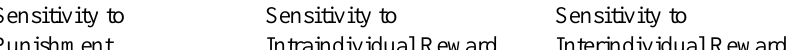
Item Sources for Measuring Dimensions of Reward and Punishment